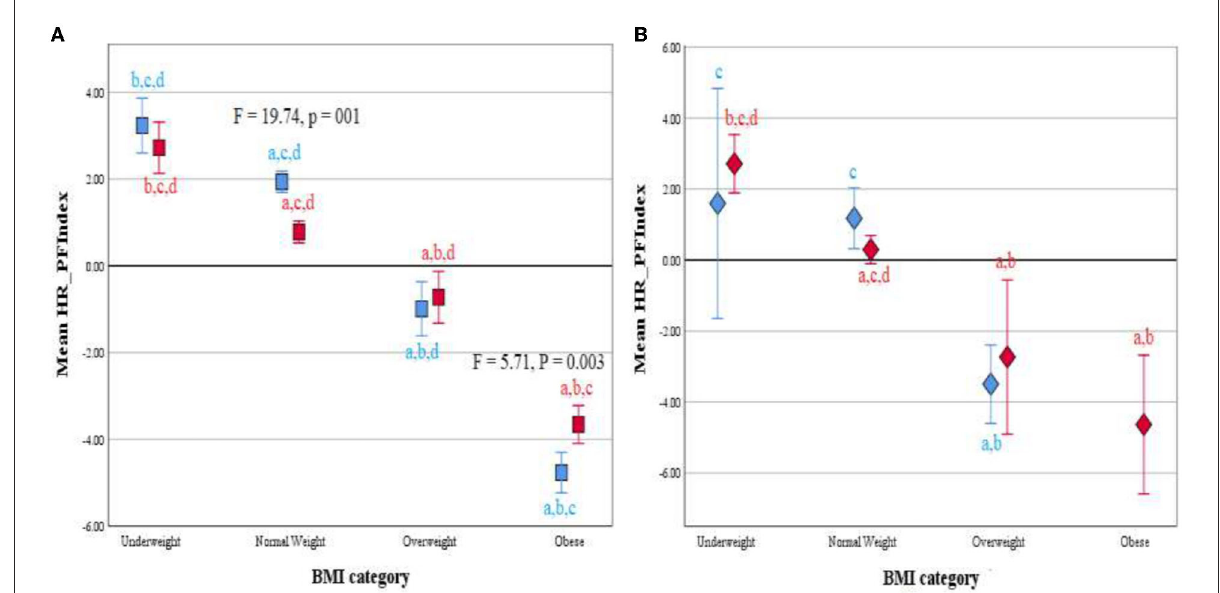
FIGURE3 Clustered Error Bar Mean of HR-PFI by BMI category and age group (Children, blue; adolescents, red) in male (A) and female (B) participants. Health-related physical fitness index, HR-PHI. a differs from Underweight; b differs from Normal weight; c differs from Overweight; d differs from Obese using